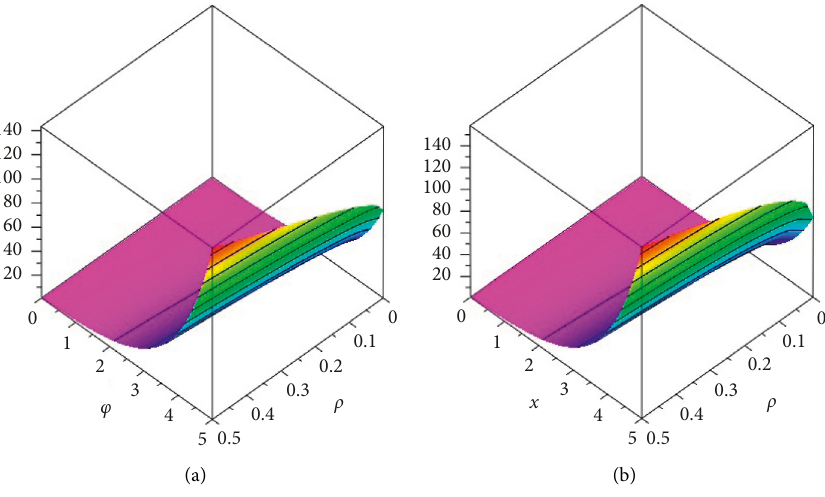
Figure 6: The graph shows the fractional order at δ � 0 . 6 and